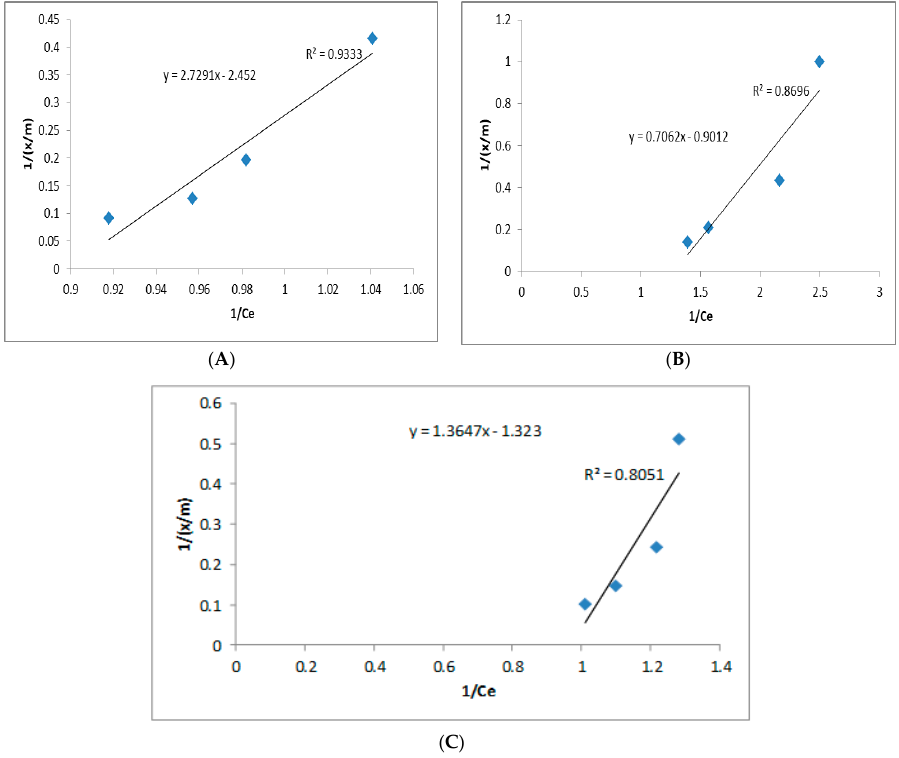
Figure 4. Langmuir isotherm regressions for ( A ) ammonia, ( B ) phenols, and ( C ) Mo.